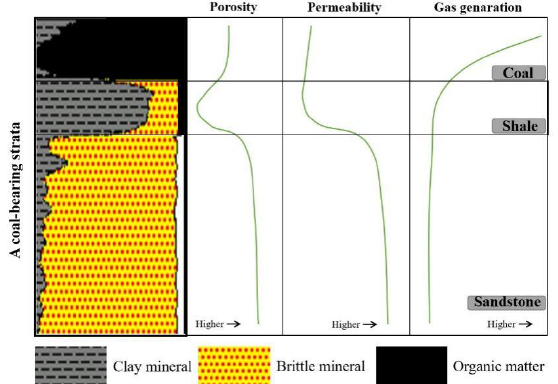
Figure 1. Three types of unconventional reservoirs in a coal-bearing stratum.